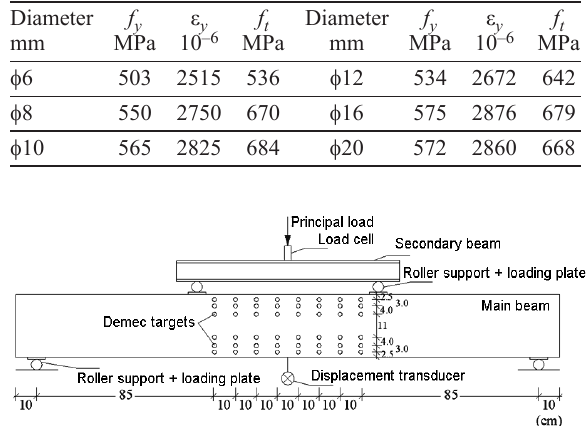
Table 3. Tensile test results for steel test specimens